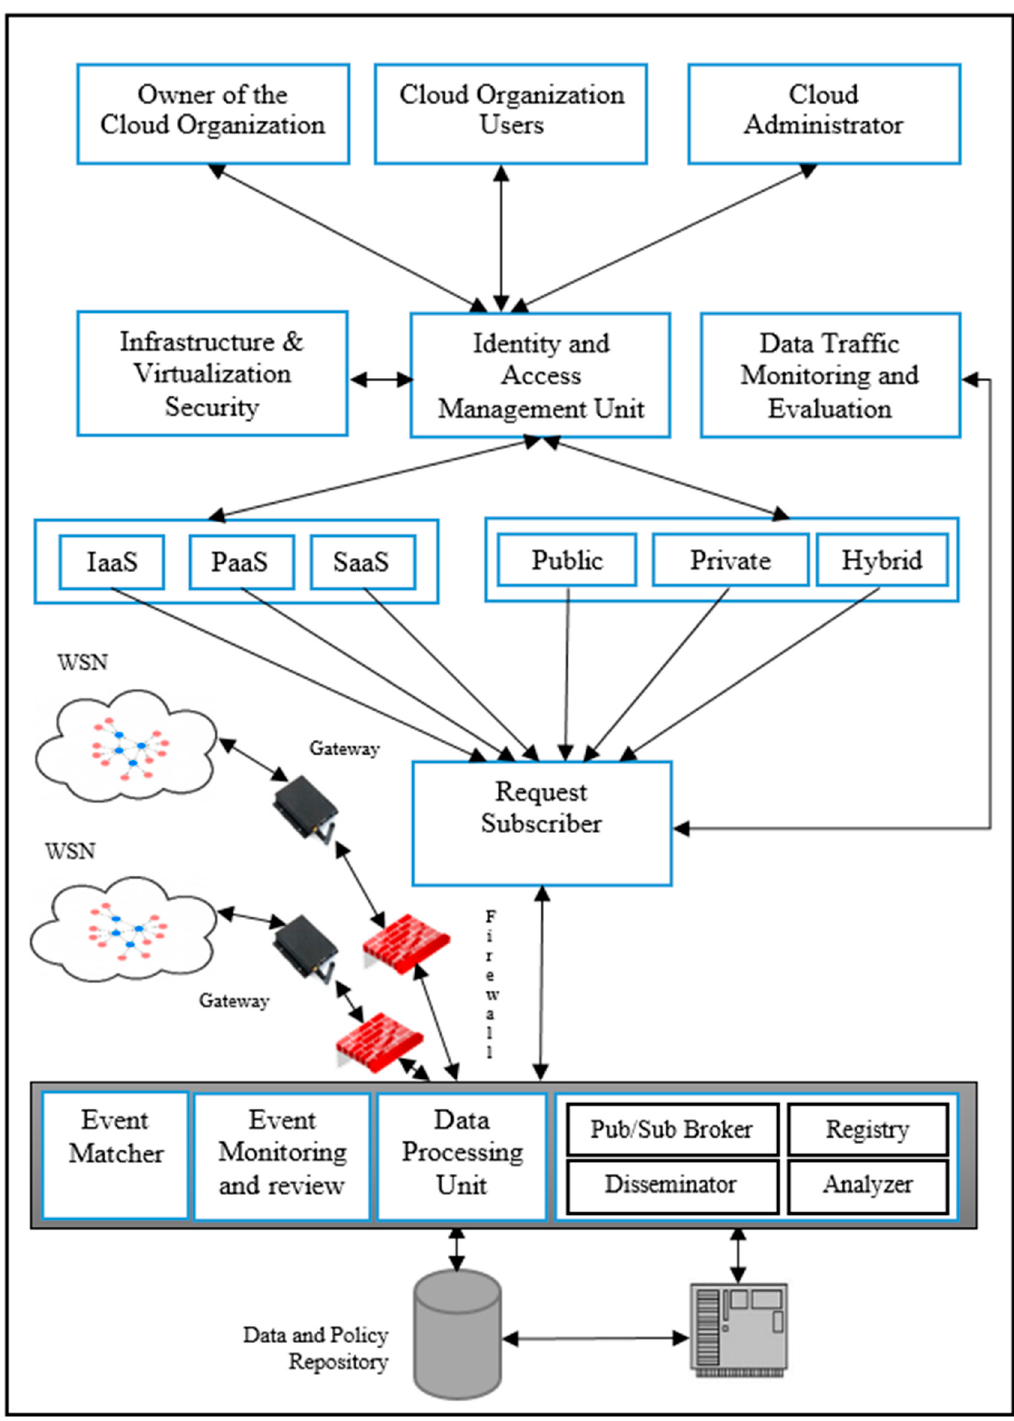
Figure 1. Integration of a WSN with a cloud network.